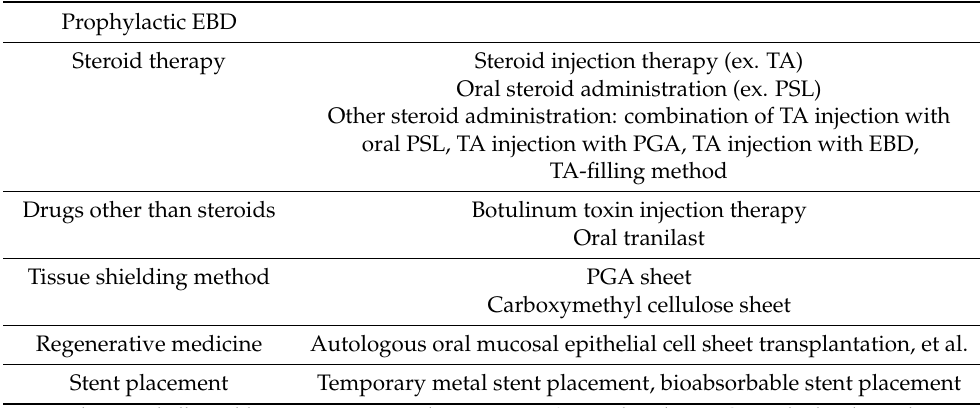
Table 1. Prevention of stricture after endoscopic submucosal dissection for esophageal for esophageal squamous cell